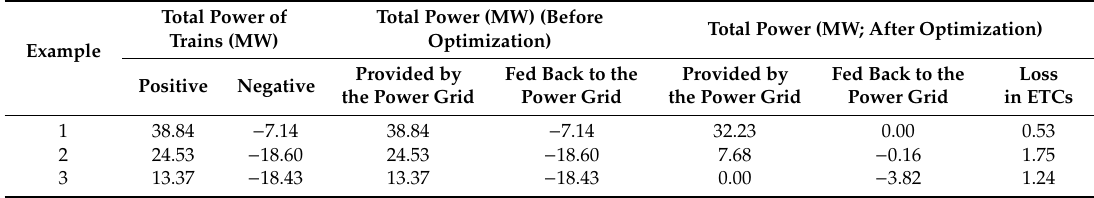
Table 1. The optimization e ff ect of the above three